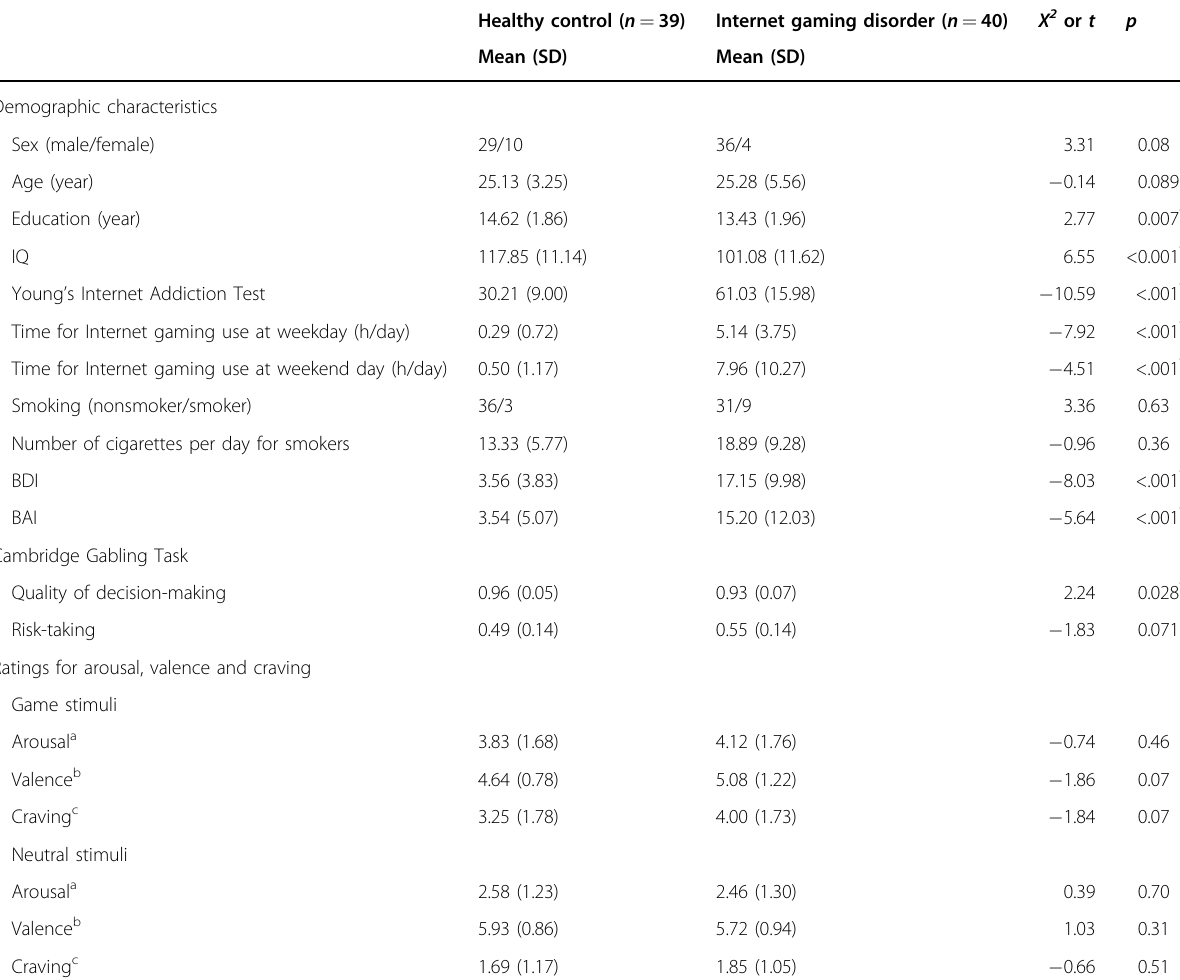
Table 1 Demographic and clinical and neurocognitive characteristics of the Internet gaming disorder and healthy control